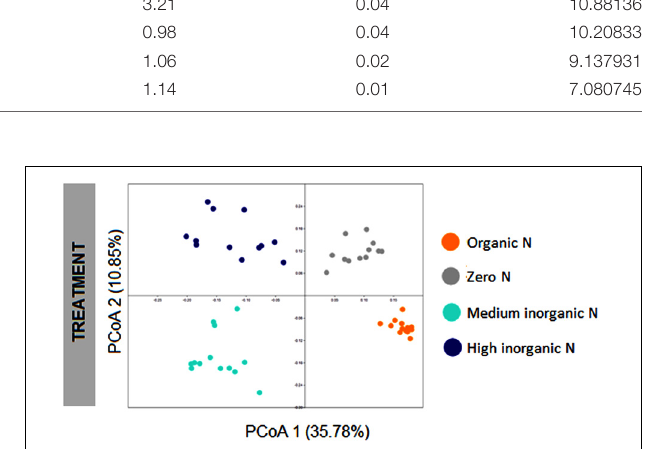
FIGURE 2 | PCoA plot based on Bray-Curtis distance matrix of bacterial communities associated with wheat grown under different fertilization regime (organic N, zero N, medium inorganic N, and high inorganic N), showing treatment as the main factor driving the structure of bacterial communities for bulk soil and rhizosphere samples collected at two stages: 4 and 10 weeks. The percentage shown in each axis corresponds to the proportion of variation